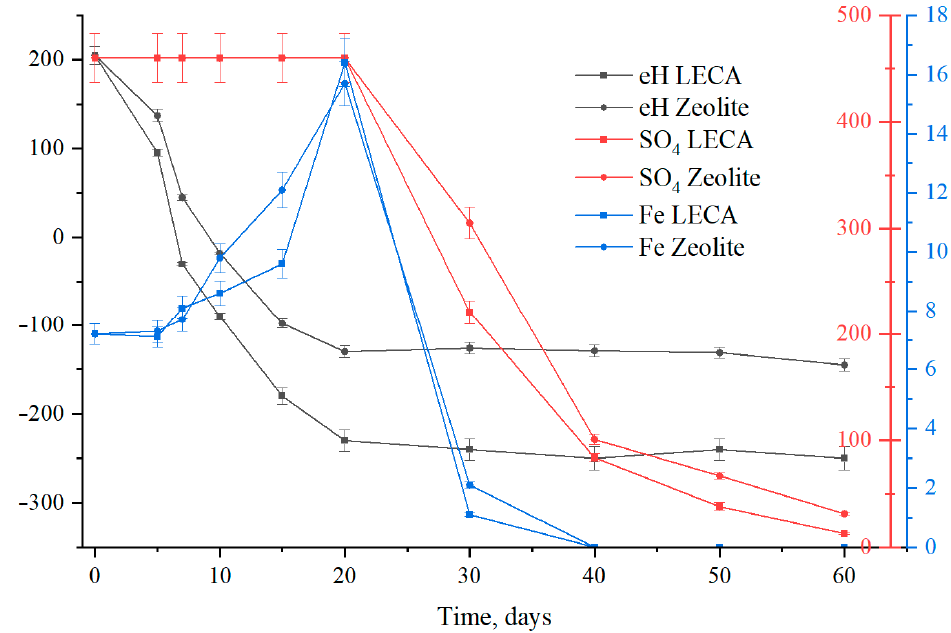
Figure 4. Kinetics of eH and Fe and SO 4–2 concentration change in solutions in biomineralization experiment.